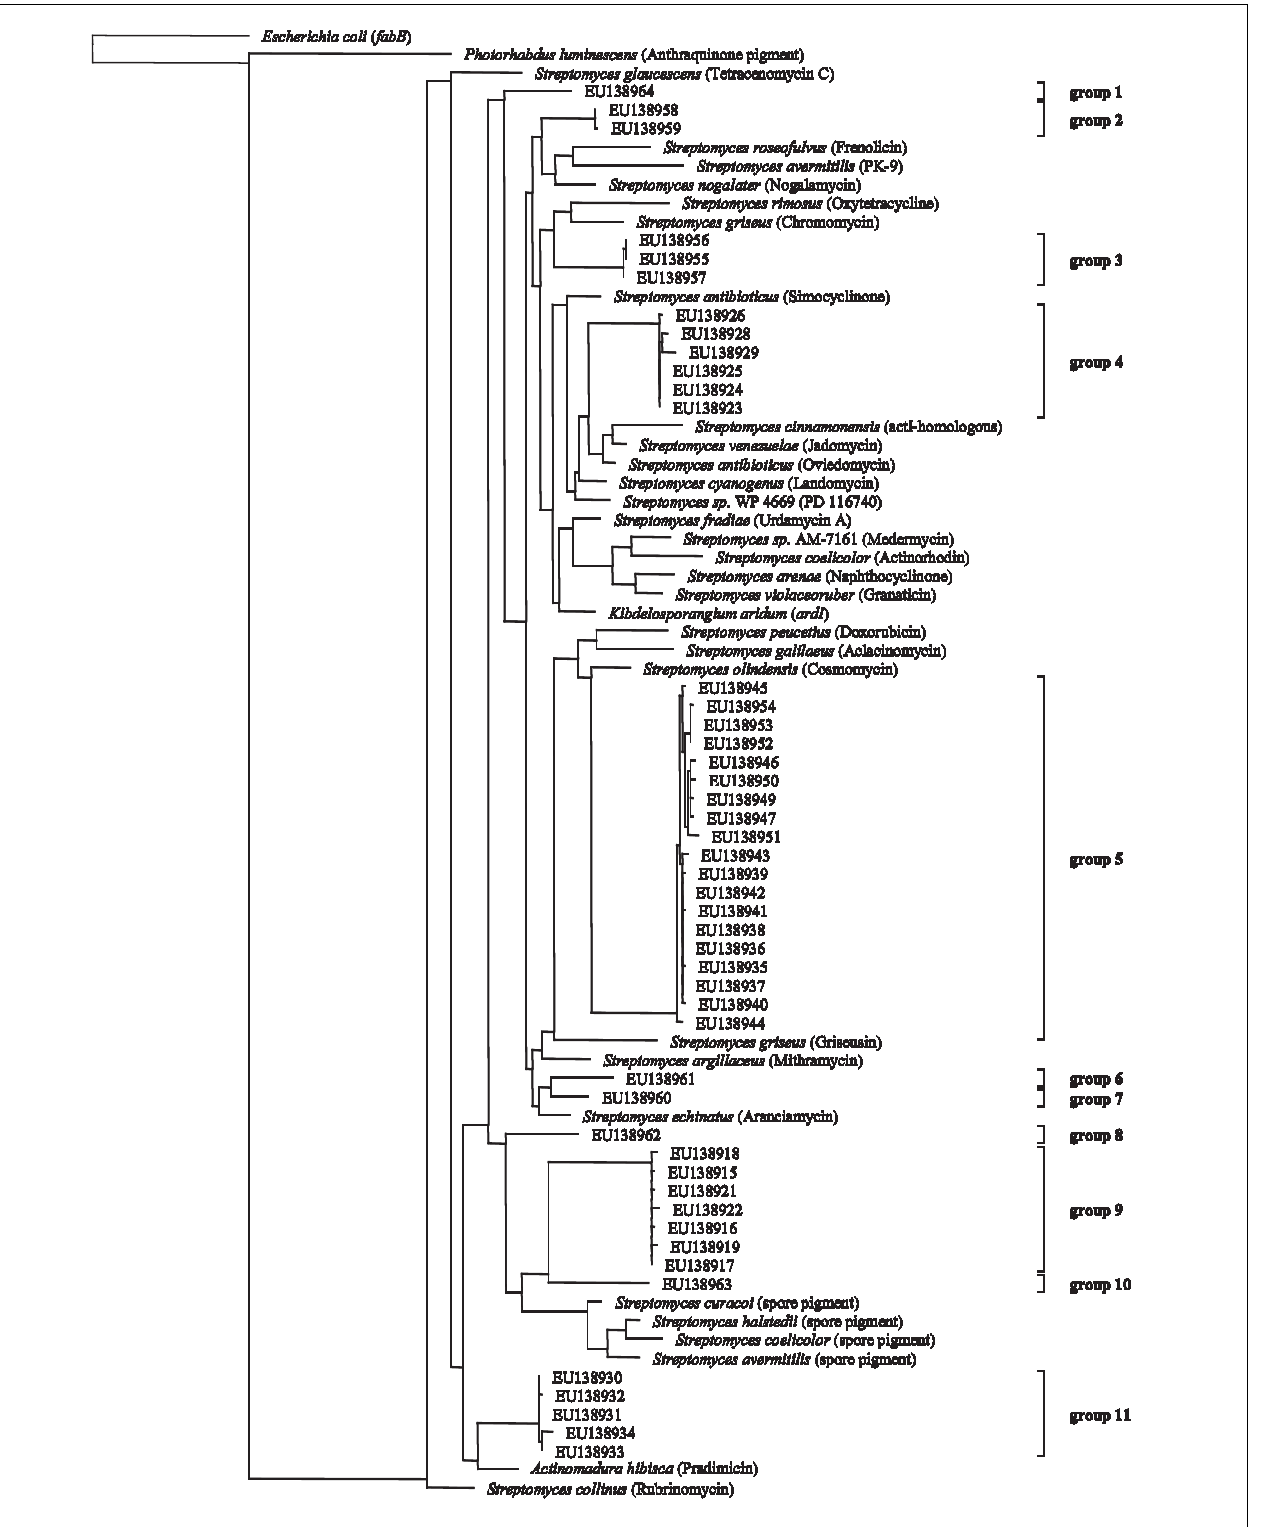
FIGURE 4 | Maximum-likelihood tree based on partial PKS type II protein sequences (185 amino acid positions) from cultured polyketide producers with known PKS Type II sequences (NCBI database) and sequences from beech rhizosphere clone library (accession numbers indicated). Tree topology was supported by